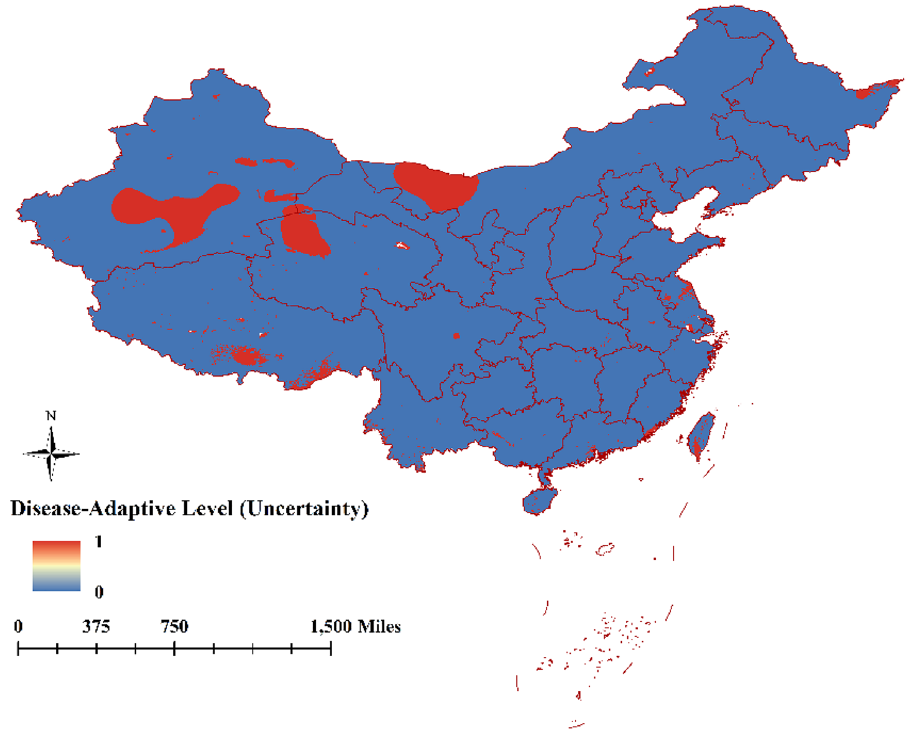
Figure 5. Model uncertainty was represented by clamping mask value. 1 (red) represents the uncertainty of the prediction model, 0.5 means that half of the model was certain and a half was uncertain, and 0 (blue) indicates that the model prediction was deterministic (The map is made by ArcGIS10.2 https:// www. esri. com/ and R 4.1.3 software https:// mirro rs. bfsu. edu. cn/